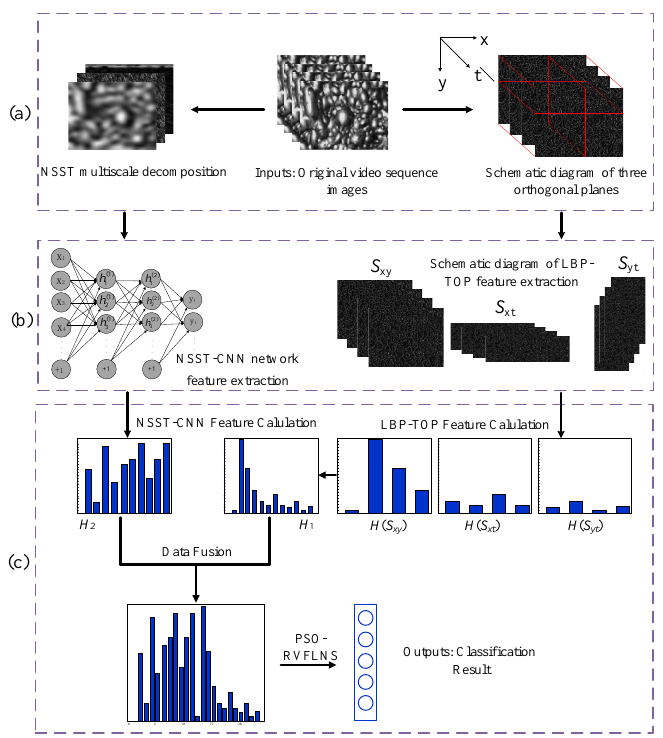
Figure 8. KRVFLNS condition recognition model combining CNN and LBP features; ( a ) NSST, RILBP feature map sequence extraction; ( b ) Multiple dimensional feature map sequence extraction; ( c ) Feature vector extraction.